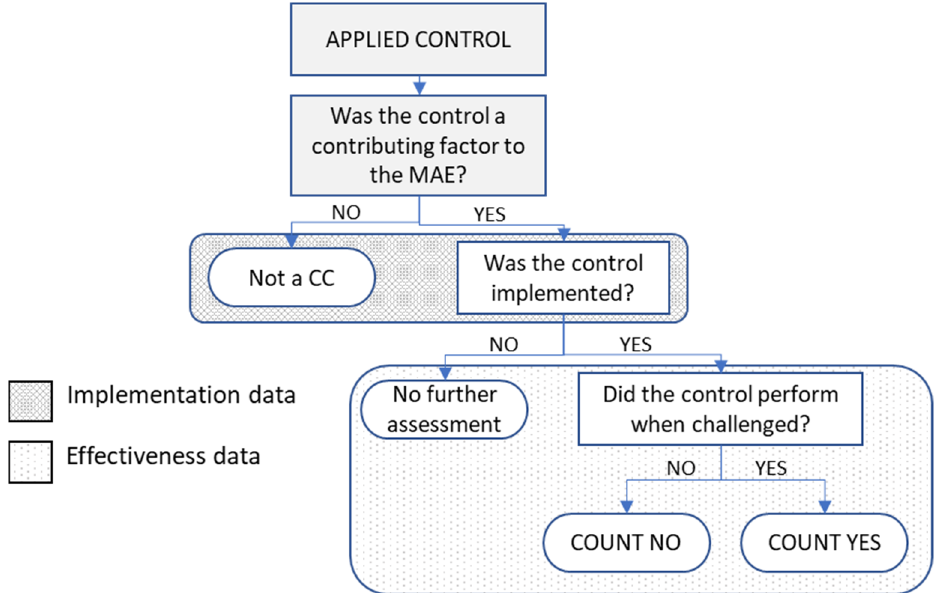
Figure 3. Process for assessing control effectiveness